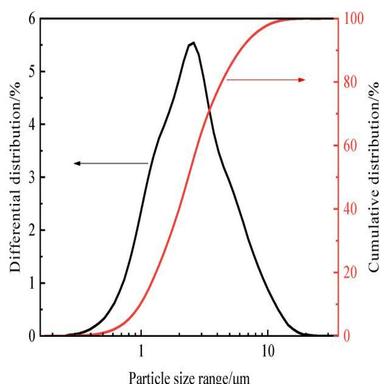
Particle-size distribution of milled powders of fly ash, calcined bauxite, and AlF3⋅3H2O.